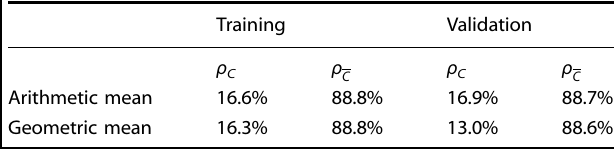
Table 1. Mean probabilities of nucleation prediction for all “ leave-two- out ”